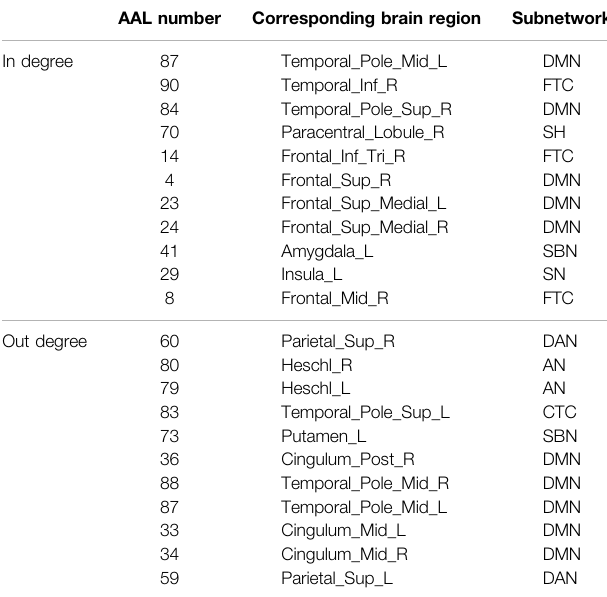
TABLE 5 | Hubs of the NC group based on the GCM